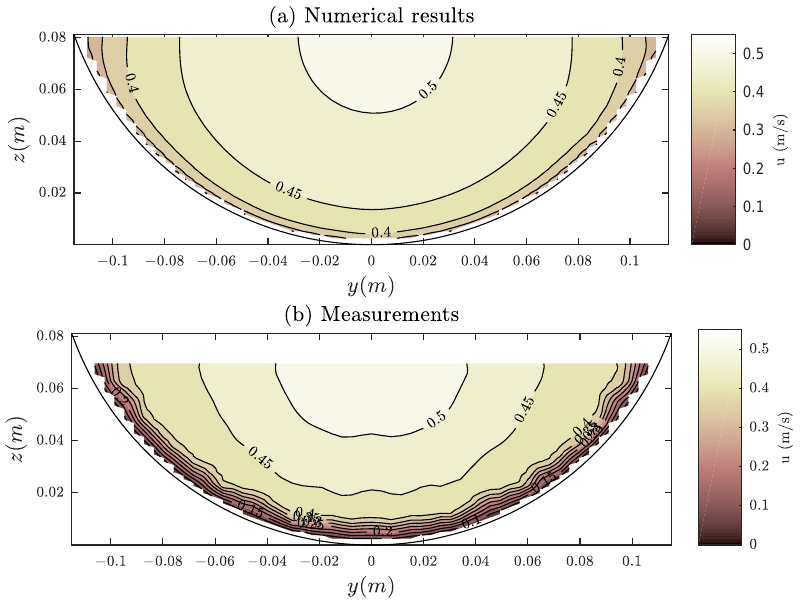
Figure 6. Comparison of calculated and measured streamwise velocity distribution in a smooth circular conduit of the experiments of Knight and Sterling